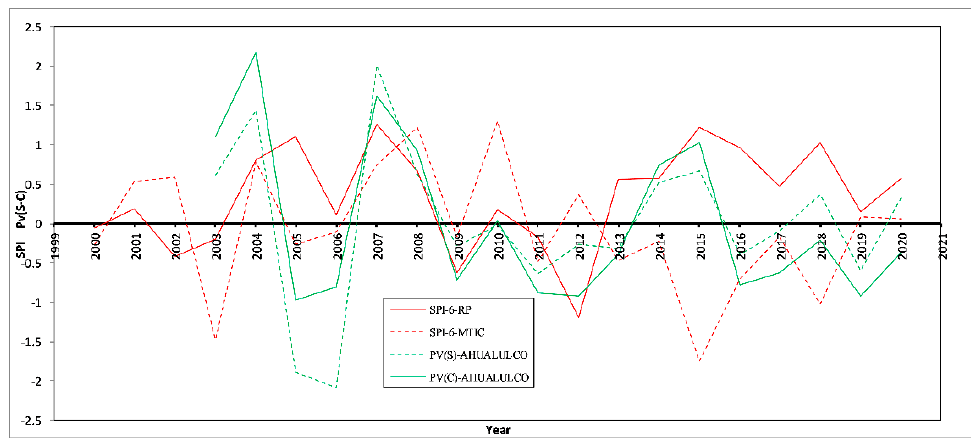
Figure 3. The behavior of the sown and harvested area vs. SPI-6. Source: Authors’ elaboration based on statistical information from CONAGUA (2020) and SIAP (2020). SPI-6-RP = Rincón del Porvenir station. SPI-6-MITIC = Mexquitic station. PV (S)-AHUALULCO = normalized value of the area sown in the spring–summer cycle in the municipality of Ahualulco. PV (C)-AHUALULCO = normalized value of the harvested area in the spring–summer cycle in the municipality of Ahualulco.